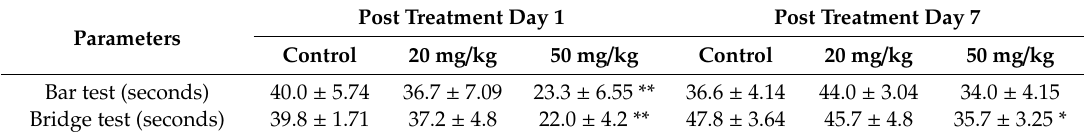
Table 5. E ff ects of Judo 40 and corn oil (control) on muscle strength and coordination of male